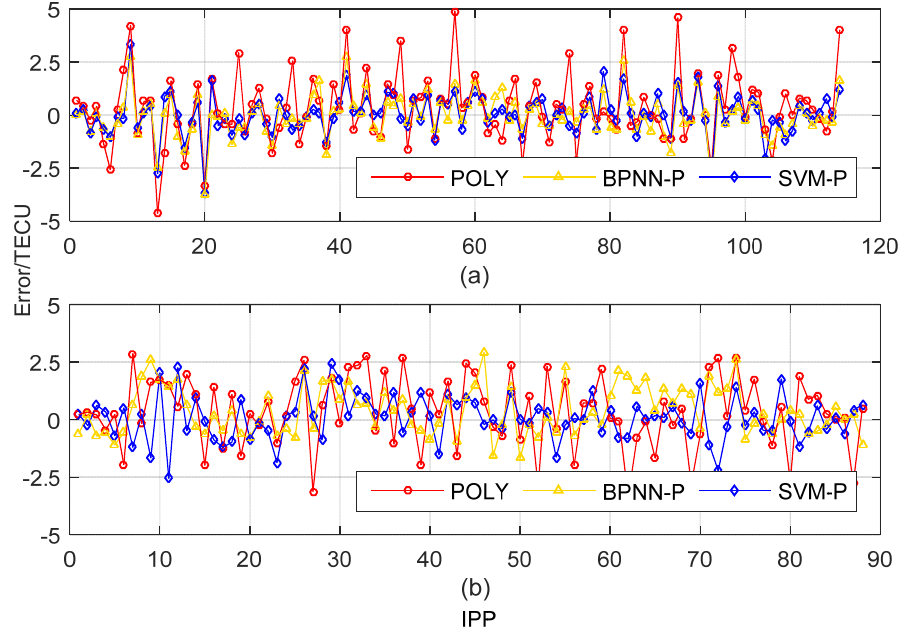
Figure 6. Total electron content (TEC) Model residuals of the test samples at two moments. ( a ) 3:00 UTC; ( b ) 19:00 UTC.